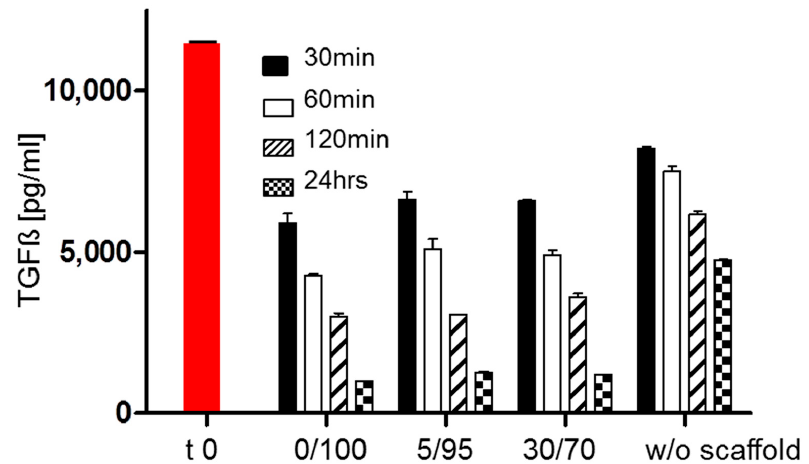
Figure 7. TGF-beta concentrations in medium containing empty scaffolds of different compositions and without any scaffold (w/o scaffold); red bar time zero; no significant differences were seen between scaffolds at same time points.